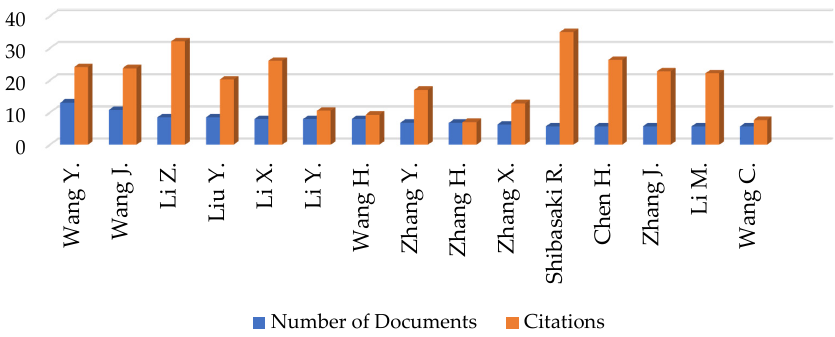
Figure 8. Authors’ names, as well as the number of documents and citations, of the 139 reviewed papers from 2010 to 2020.